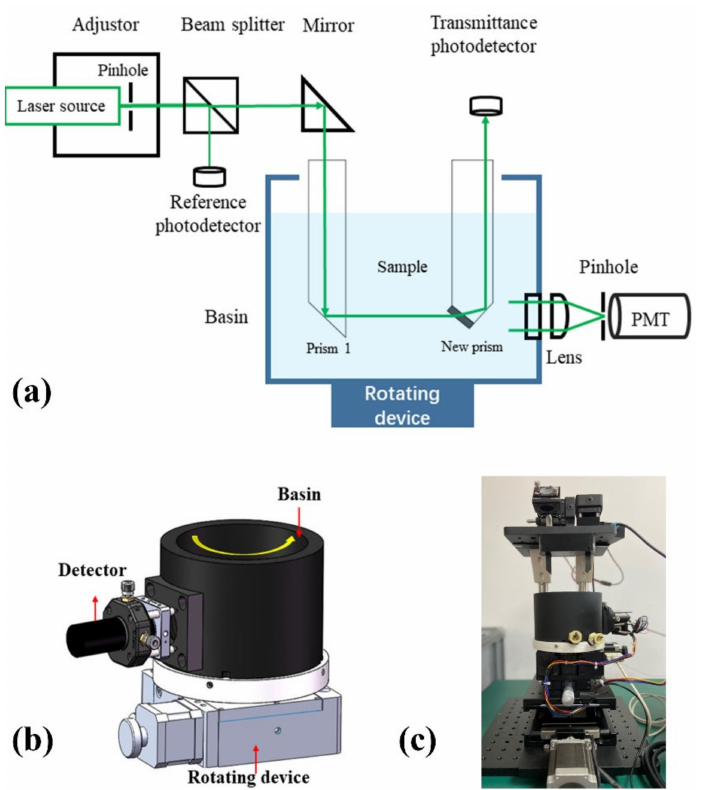
Figure 1. ( a ) Schematic of the measurement principle of the VSF instrument. The wavelength of the laser source is 532 nm (as an alternative, the 520 nm CW laser module of MatchBox TM is available). The pinhole is used to block the divergent stray light of the laser source. The adjustor is set for the adjustment of the laser source’s tilt angle. The beam splitter separates the laser into two beams: reflected beam and transmitted beam. The reflected beam is detected by the reference photodetector. The transmitted beam enters the sample via the mirror and prism 1, leaves the sample via the new prism, and is detected by the transmittance photodetector. Scattered light is detected by the photomultiplier tube (PMT) that spins along with the rotating device and basin. ( b ) Schematic of the rotatable component. The basin is used to store the sample where scattering occurs. The detector is rotated following the direction of the yellow arrow together with the basin driven by the rotating device. ( c ) Exhibition of